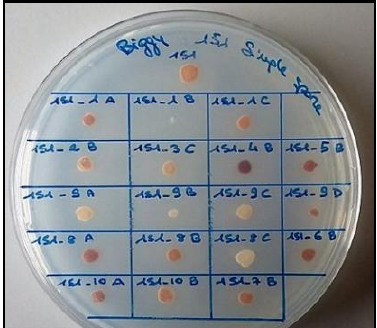
Figure 1. Different level of H 2 S production of the spores. The different color intensity of the colonies indicates different levels of H 2 S production. White colonies were H 2 S - while brown/black colonies expressed maximum level of H 2 S. An intermediate color intensity indicated medium production of H 2 S.